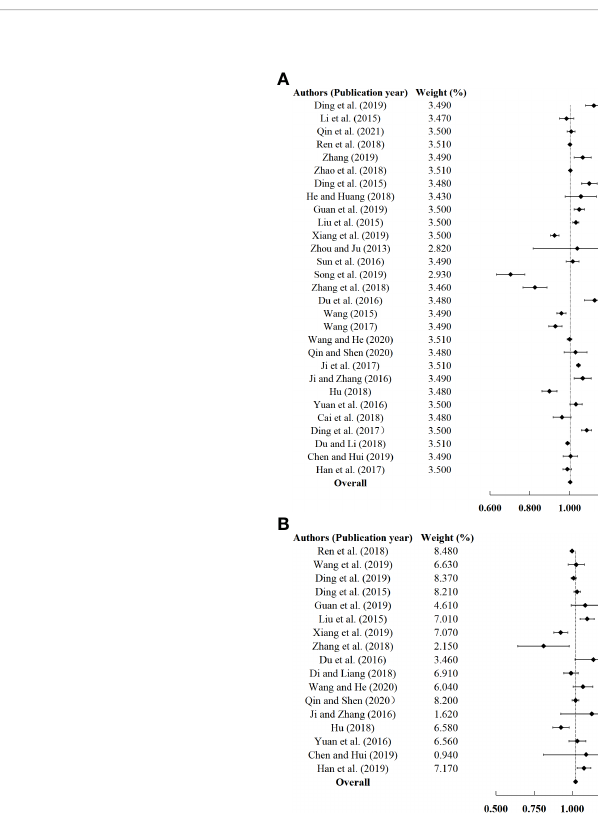
FIGURE 2 Forest plot of the weighted effect sizes and their 95% con fi dence intervals (CI). (A) Forest plot at the provincial level; (B) Forest plot at the national level. The solid vertical line represents a mean difference of zero or no effect. Points to the left of the line represent a reduction in fi nal TFP growth, while points to the right of the line indicate an increase. Each diamond around the point effect represents the mean effect size for that study and re fl ects the relative weighting of the comparison to the overall effect size estimate. The weights that each comparison contributed are in the left- hand column. The upper and lower limit of the line connected to the diamond represents the upper and lower 95% CI for the effect size. The overall polled effect size pooled using the random effects models are indicated by the respective diamonds at the bottom.